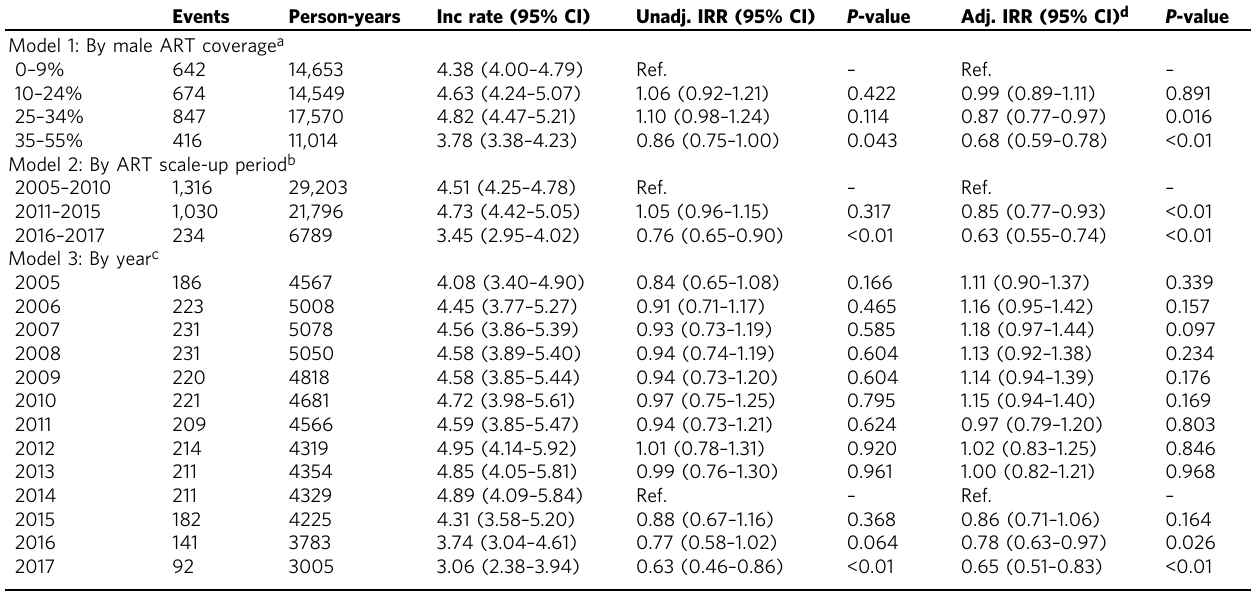
Table 3 Incidence rates (IRs, unadjusted) and incidence rate ratios (IRRs, unadjusted and adjusted) for women ( N = 12,609) by male ART coverage, ART scale-up period, and